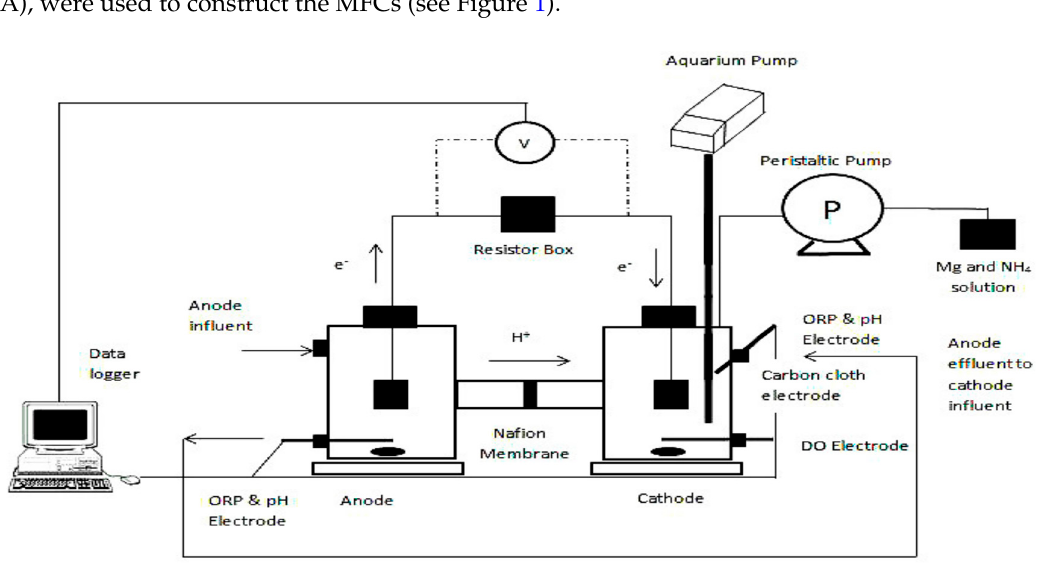
Figure 1. Experimental set-up of the dual-chamber MFC.